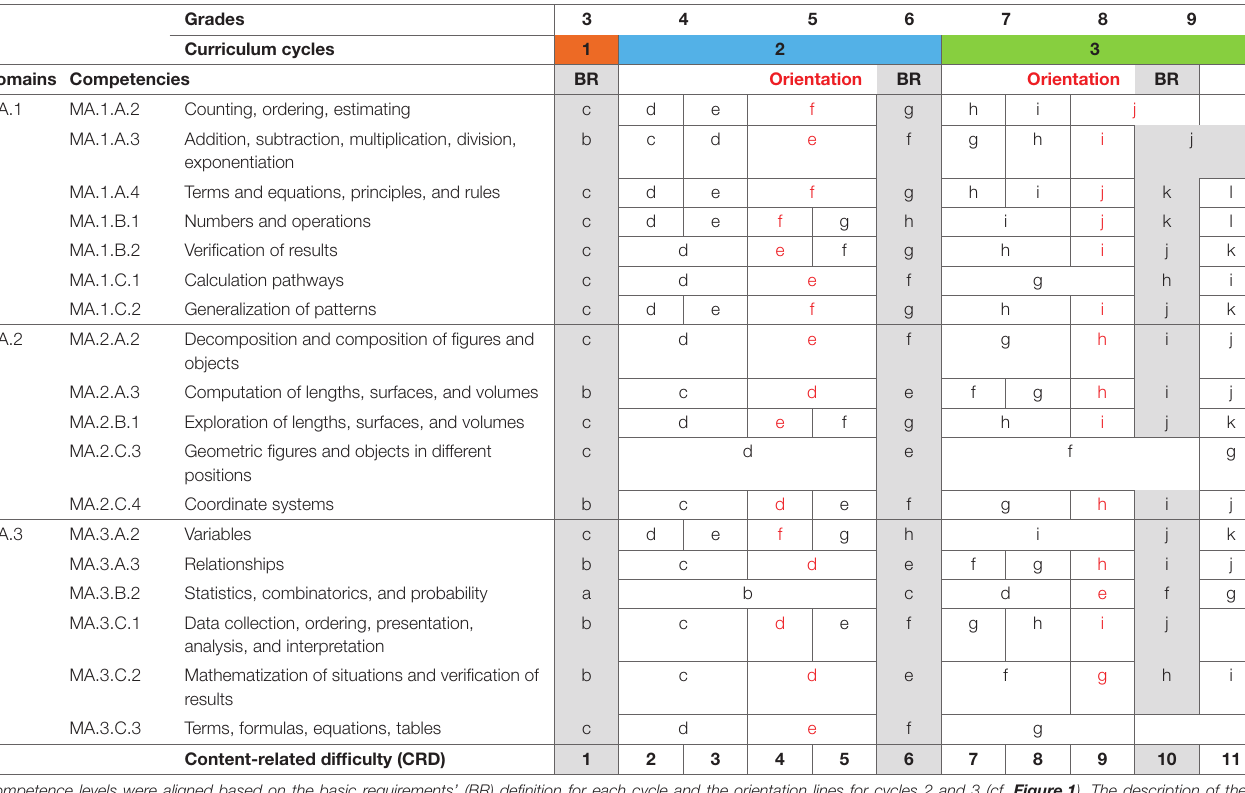
Competence levels were aligned based on the basic requirements’ (BR) definition for each cycle and the orientation lines for cycles 2 and 3 (cf. Figure 1 ). The description of the competencies represents a simplification of the original descriptions, which can be found in the curriculum (D-EDK, 2016a). MA.1 = “number and variable,” MA.2 = “form and space,” and MA.3 = “measures, functions, data, and